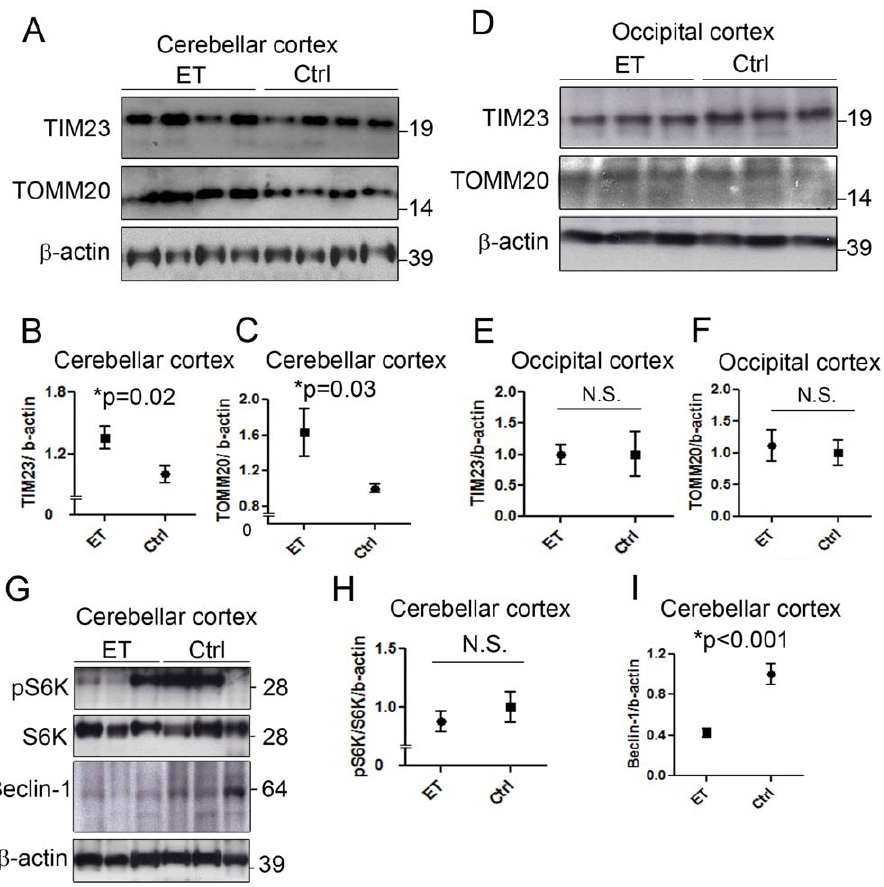
Figure 3. Mitochondrial accumulation and beclin-1 deficiency in ET cerebellum. Levels of mitochondrial membrane protein, TIM23 and TOMM20, in cerebellar cortex homogenates in 10 ET cases and 11 controls were determined by Western blot and the representative bands were shown (A). TIM23 and TOMM20 were normalized against b -actin to determine the protein levels. TIM23 and TOMM20 protein levels were significantly higher in the cerebellum of ET cases than controls (B, C). In contrast, TIM23 and TOMM20 protein levels were similar in the occipital cortex of 7 ET cases and 9 controls (D–F). S6K, pS6K, and beclin-1 levels in cerebellar cortex homogenates were determined by Western blot (G). pS6K levels were highly variable (G). pS6K and S6K ratio did not differ between ET cases and controls (H). Beclin-1 level was significantly lower in ET cases than